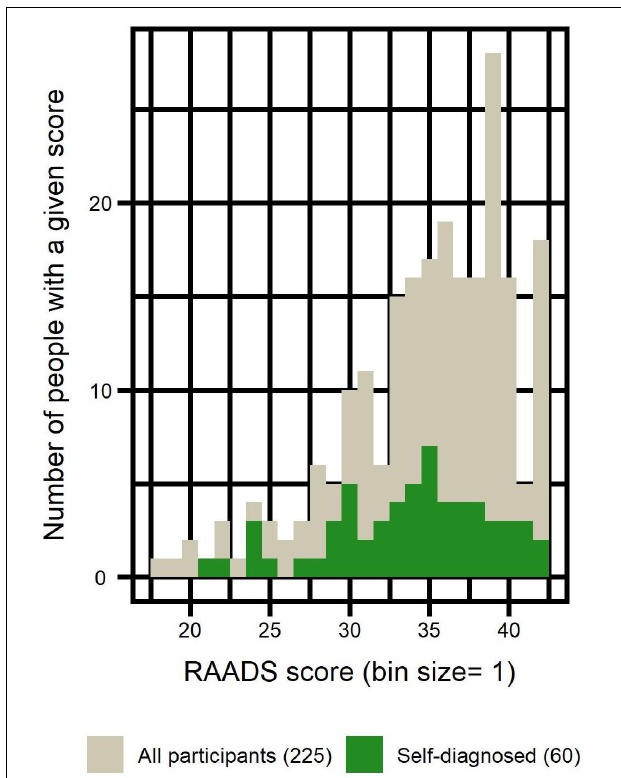
FIGURE 1 | Distribution of RAADS scores of self-diagnosed participants compared to the distribution of all participants.